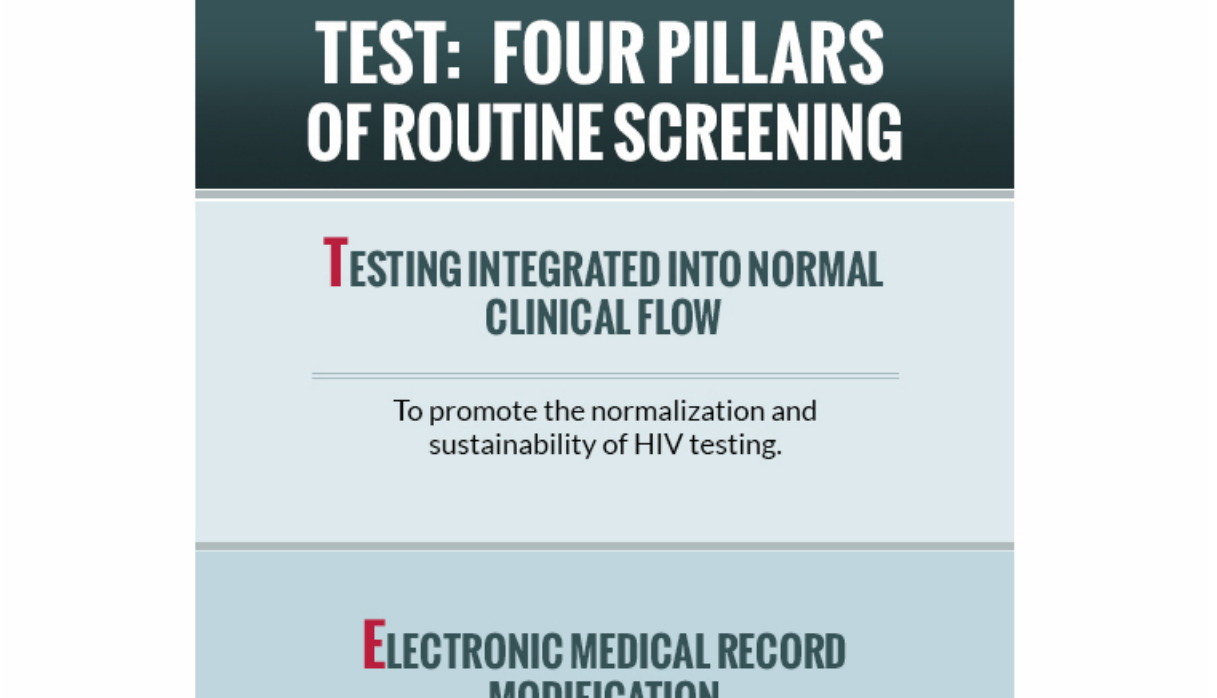
Figure 4. TEST: four pillars of routine HIV screening in clinical